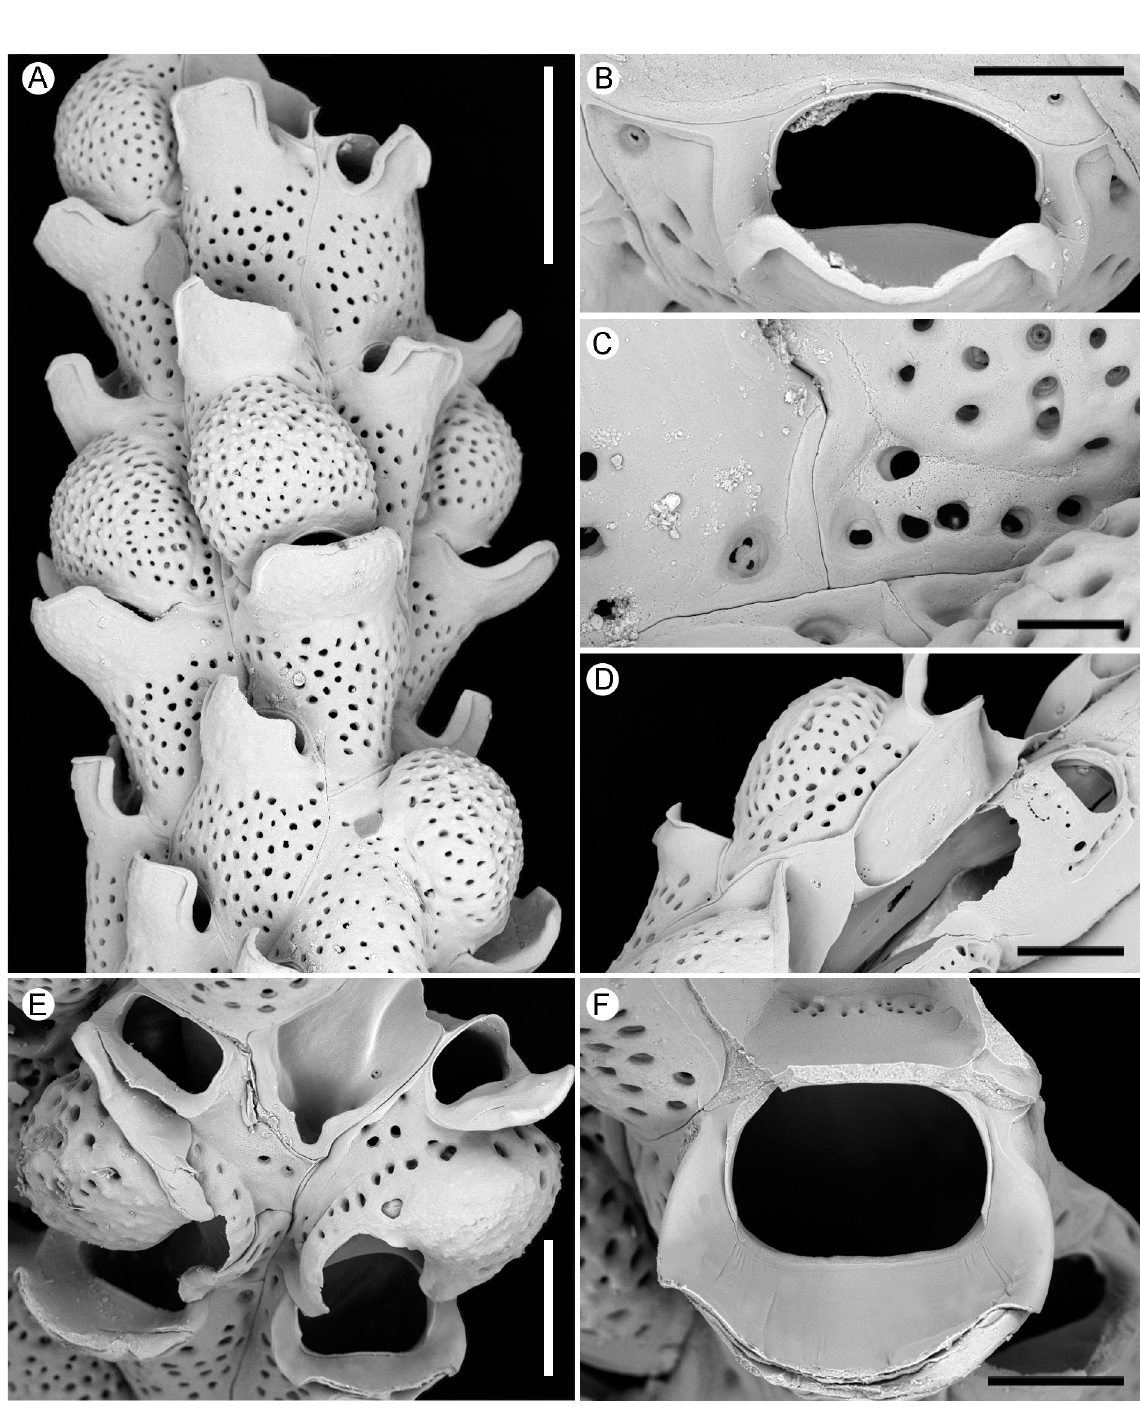
Fig. 3. Powellitheca labiosa gen. et sp. nov. NIWA 98320 (A–C, E–F), 98229 (D), Recent, Three King Islands, New Zealand. A . Group of fertile zooids and autozooids. B . Tilted view of the primary orifice of an autozooid. Note the lack of a lyrula. C . Close-up of the frontal, multiporous septula on the distolateral corners and the funnel-shaped pseudopores on the frontal shield. D . Lateral, multiporous septula on the zooidal vertical walls. E–F . Tilted view of the orifice of fertile zooids. Scale bars: A = 500 µm; B–C = 100 µm; D = 200 µm; E = 250 µm; F = 150